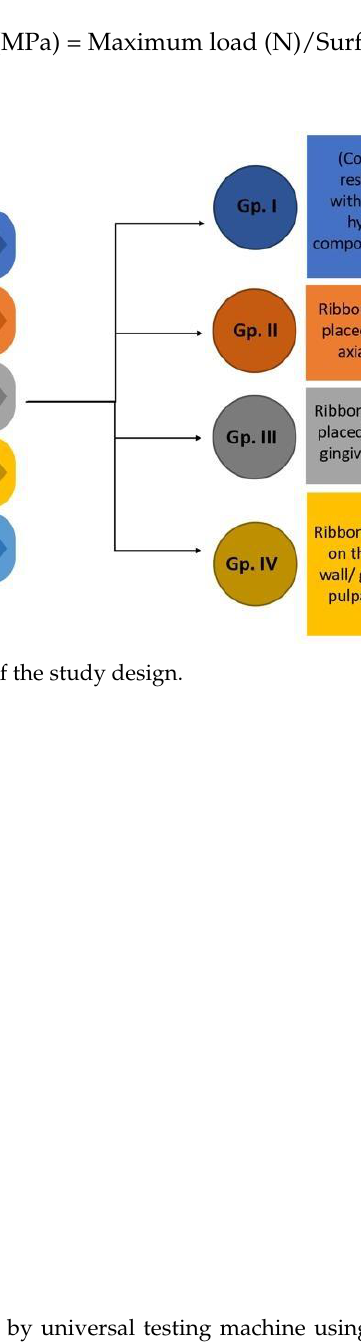
Figure 2. Fracture strength test by universal testing machine using a 3 mm diameter steel ball con- tacting the restoration at the isthmus area at a crosshead speed of 0.5 mm/min until fracture.